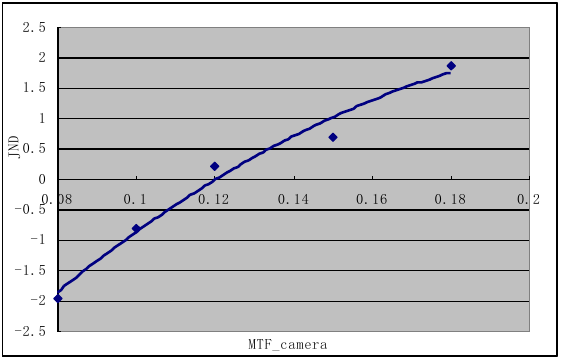
Figure 3. Relationship of camera MTF and JND